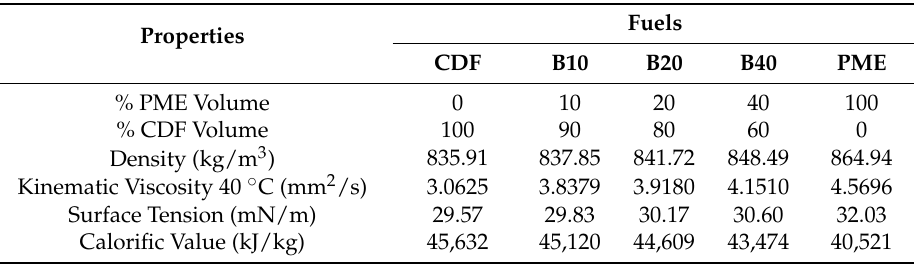
Table 1. Properties of conventional diesel fuel (CDF), palm biodiesel blends and palm methyl ester (PME).